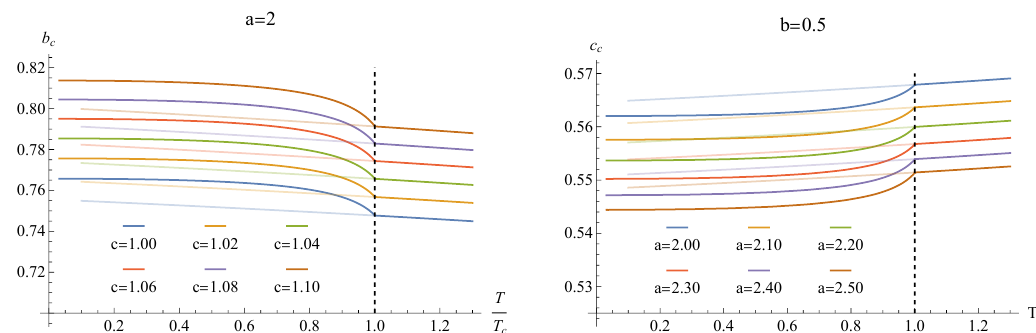
Figure 10 . The critical configuration for disentangling phase transition. The critical temperature is indicated by the black dashed line. The solid and translucent lines represent stable and metastable states. Left plot: when b is above the b c , the disentangling phase transition occurs. Right plot: when c is below c c , the disentangling phase transition occurs.